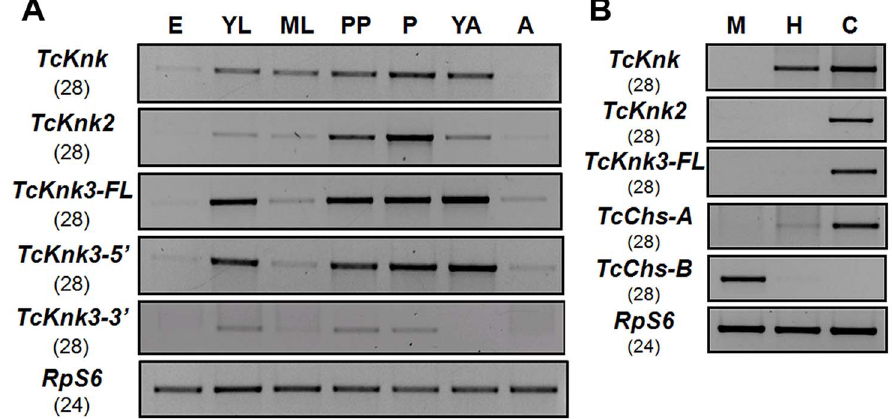
Figure 5. Developmental stage-specific and tissue-specific expression of TcKnk -family genes by RT-PCR. (A) Developmental expression profiles of TcKnk (includes data on TcKnk1 taken from [11]) for the purpose of comparison, TcKnk2 , TcKnk3-FL , TcKnk3-5 9 and TcKnk3-3 9 transcripts. cDNAs were prepared from total RNA extracted from whole insects at several developmental stages including E, embryos; YL, young larvae (penultimate instar or younger); ML, mature larvae; PP, pharate pupae; P, pupae; YA, young adults (0 d- old); A, mature adults (10 d-old). (B) Tissue- specific expression of TcKnk -family genes in the feeding stage last instar larvae. M, midgut; H, hindgut; and C, carcass (whole body without gut). T. castaneum ribosomal protein-S6 ( TcRpS6 ) was used as internal loading control for RT-PCR. Results are from 28 and 24 cycles of RT-PCR for TcKnk - family genes and TcRpS6 , respectively. TcChs-A (chitin synthase-A) (epidermis-specific) and TcChs-B (chitin synthase-B) (midgut-specific) expression was also measured to rule out cross contamination with RNA from non-targeted